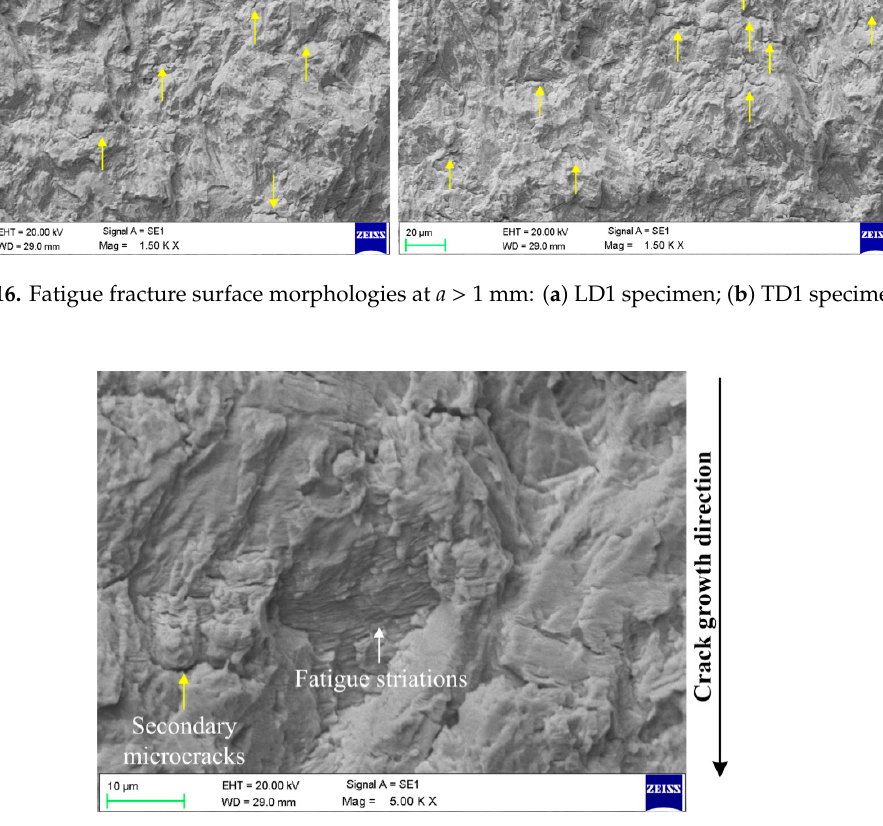
Figure 17. Fatigue striations and secondary microcracks.